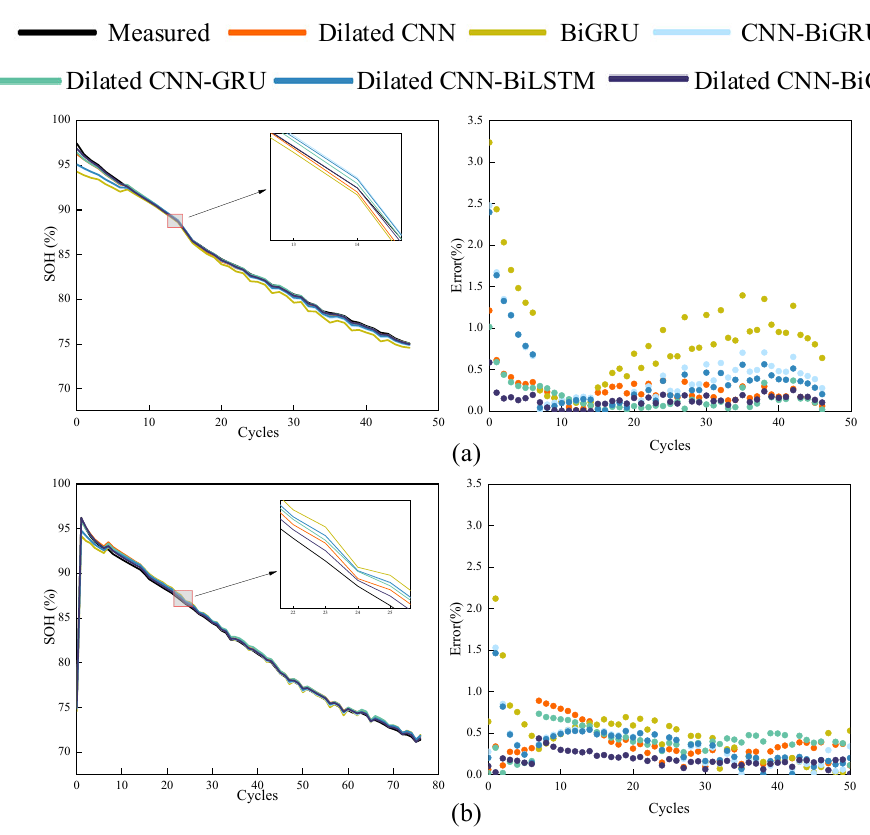
Figure 11. Estimation accuracy and estimation error of the testing set for the NASA dataset. ( a ) Cell 4, ( b ) Cell 8. Table 3. MAEs and RMSEs of SOH estimation on the Oxford dataset.